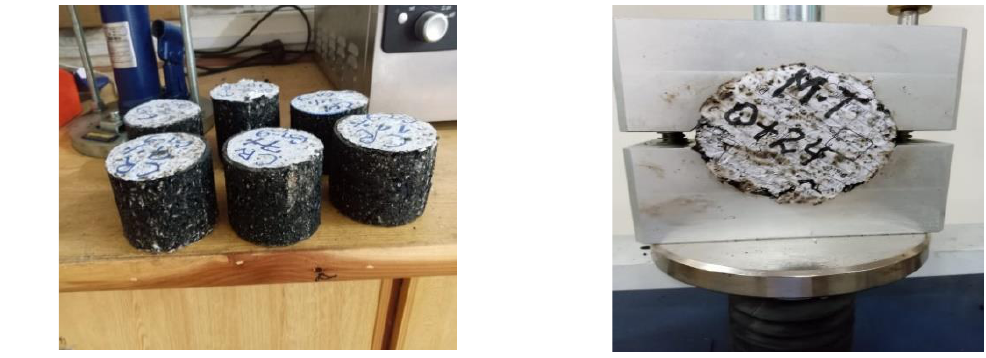
Figure 4. Asphalt concrete samples for Marshall stability testing. Table 5. National Highway Authority (NHA) class “A” materials selection criteria .